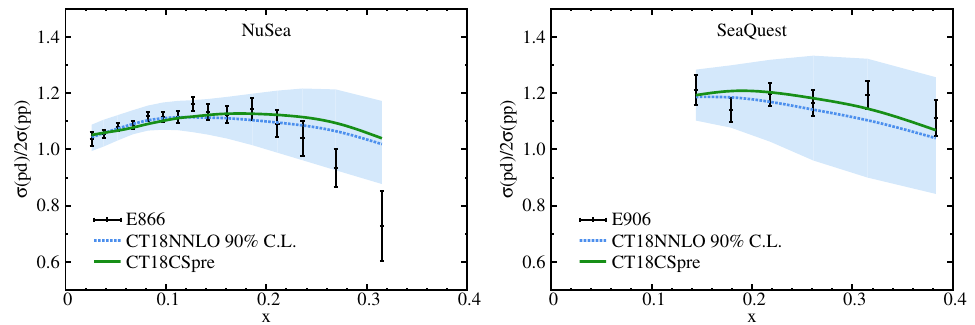
Figure 4: Comparisons of predictions by CT18CSpre (green curves) and CT18NNLO (blue curves) to the NuSea E866 [ 12 ] and SeaQuest E906 [ 15 ] data,